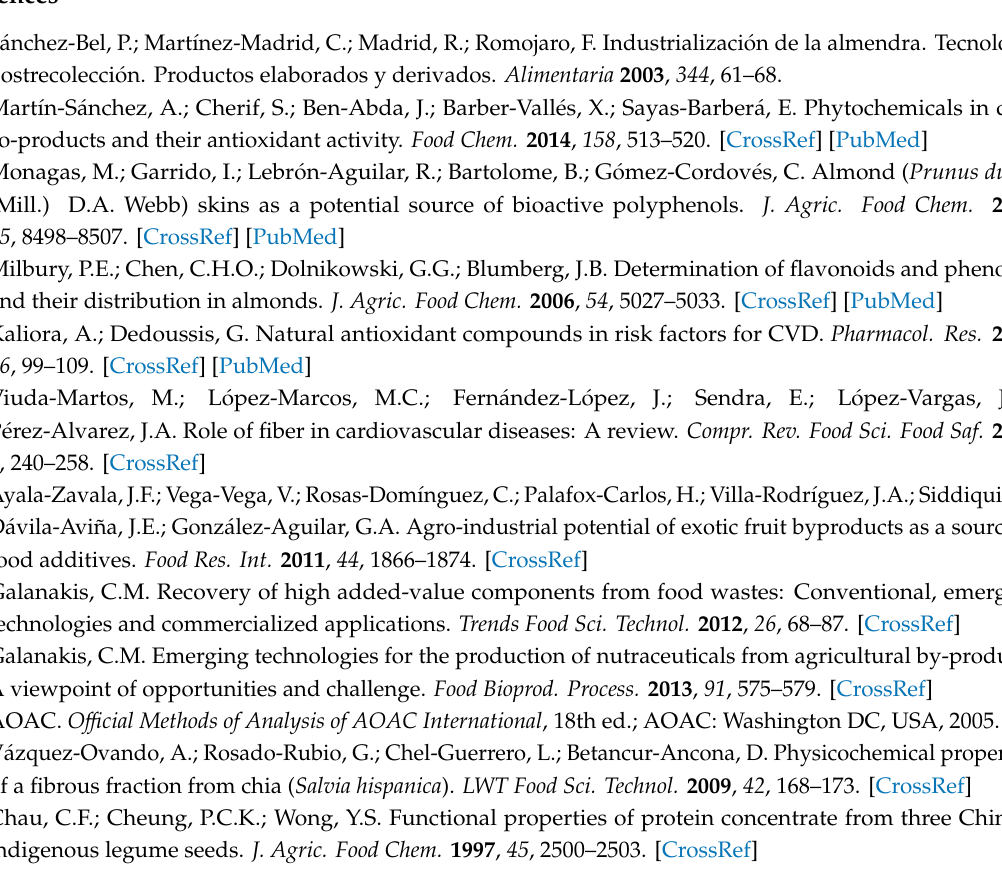
Table S1: Precursor ions ( m / z ), fragment ion transitions and main UHPLC-MS / MS optimized